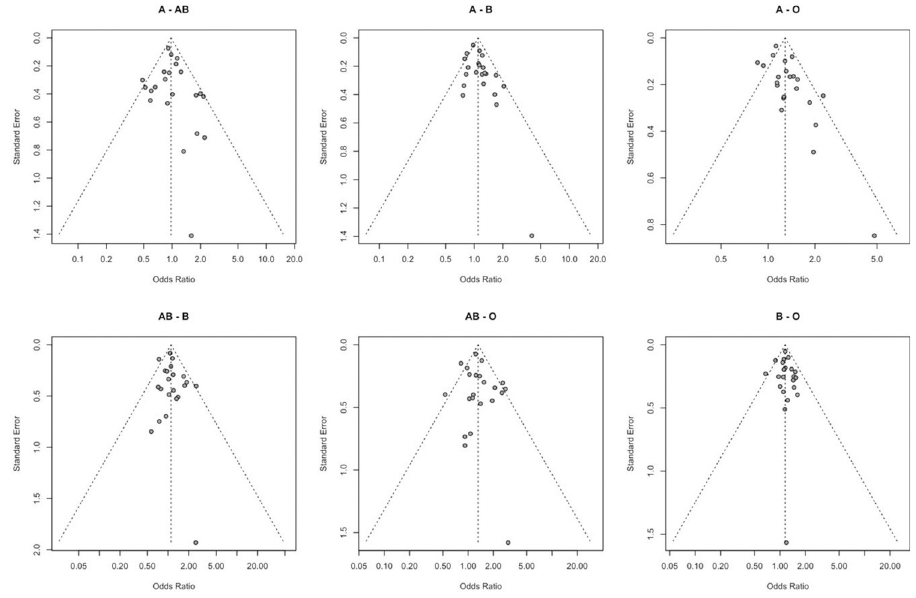
Fig 8. Funnel plots for the ABO gene.